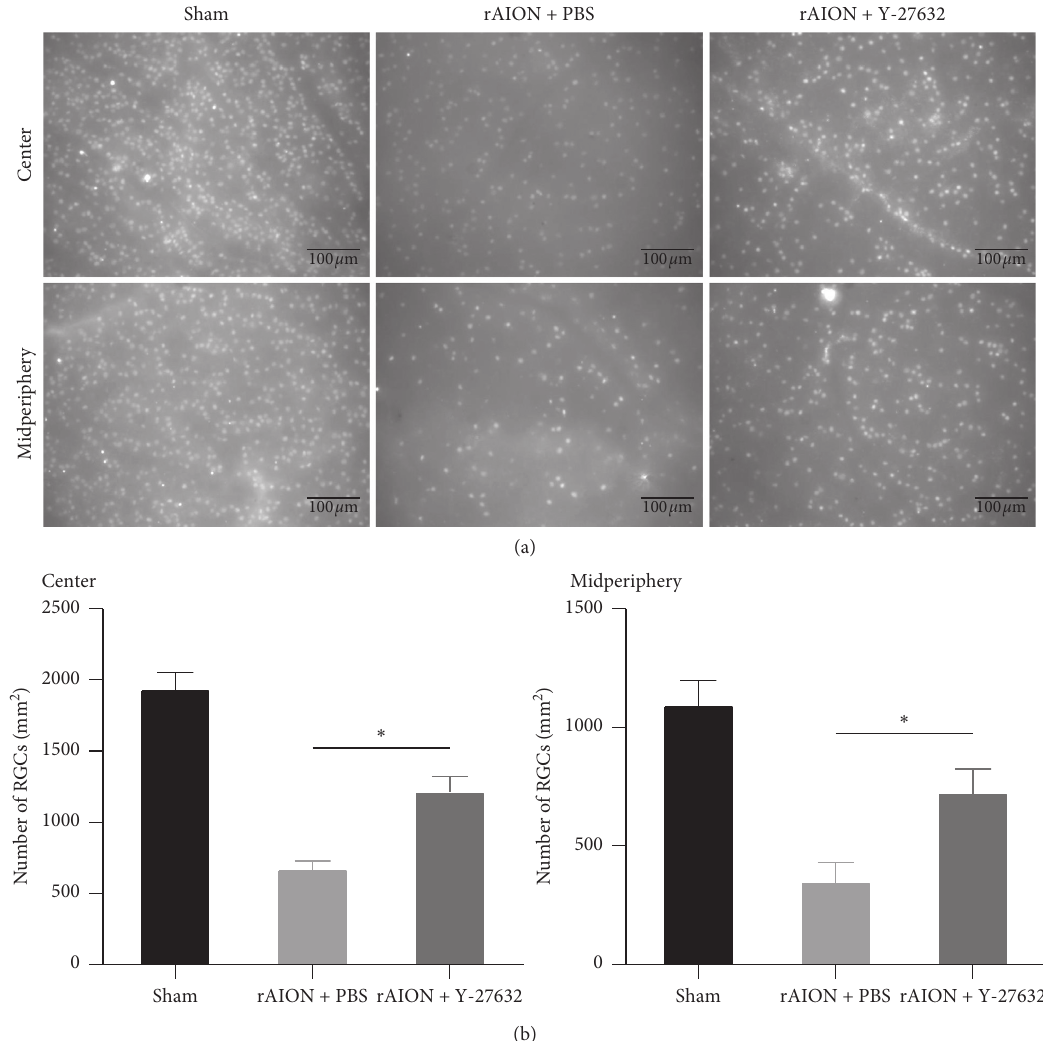
Figure 5: Survival of RGCs at 28 days after induction. (a) Representative central and midperipheral flat-mounted retinas showing RGCs labeled by Brn3a antibody; (b) quantification of RGC densities in the central and midperipheral retinas in each group. The RGC densities within the central and midperipheral retinas were significantly higher in the Y-27632-treated group than in the PBS-treated group ( n � 6 per group). The asterisk indicates p < 0 . 05, as determined by the Kruskal–Wallis test. Scale bar: 100 μ